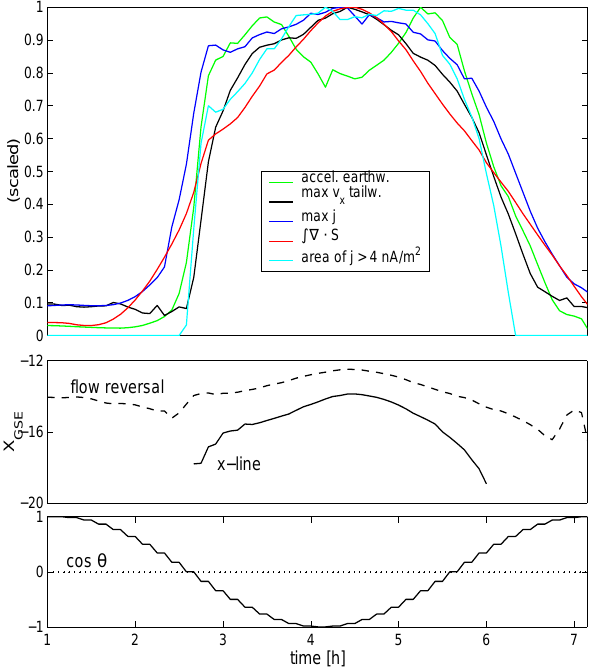
Fig. 7. Time development of several reconnection-related quanti- ties, in the IMF rotation run with small dynamic pressure and large IMF magnitude. Uppermost panel, black: maximal flow speed tail- wards. Green: earthward flow speed, measured 2 R E earthward of the flow reversal. Dark blue: maximal total current density on the current sheet. Light blue: area of that part of the current sheet where current density exceeds 4nA / m 2 . Red: volume integral of the di- vergence of the Poynting vector. Middle panel, solid line: the x coordinate of the magnetic x-line directly behind the earth, at y=0. Dashed line: the same for the flow reversal